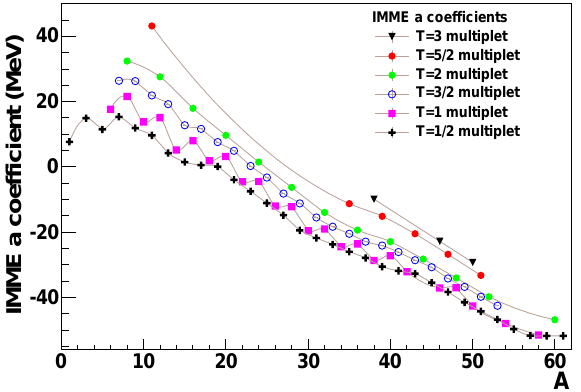
Figure 1. a coe ffi cients, in MeV, shown as a function of atomic mass number A extracted from a second degree IMME polynomial fit: a + bT z + cT 2 . This coe ffi cient is the mass excess of the excited N = Z nuclide for integer z isospin values, and is more di ffi cult to interpret